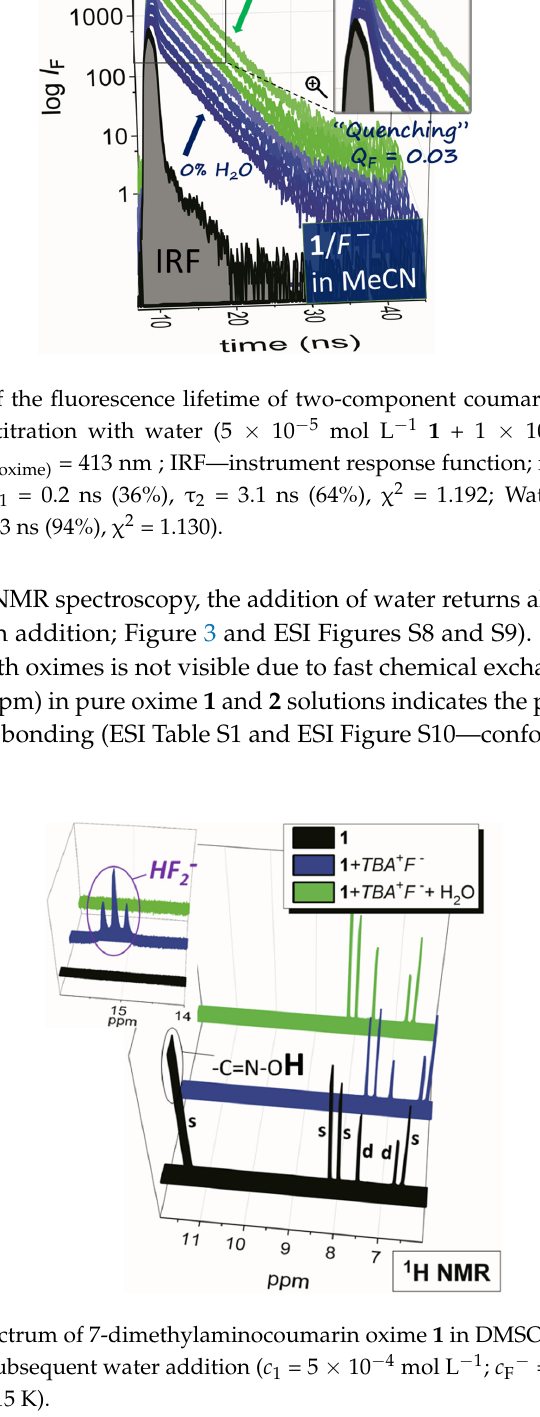
Figure 3. 1 H NMR spectrum of 7-dimethylaminocoumarin oxime 1 in DMSO- d 6 before and after F − anion (TBA + F − ) and subsequent water addition ( c 1 = 5 × 10 − 4 mol L − 1 ; c F − = 1 × 10 − 1 mol L − 1 ; 4% ( v/v ) of water; T = 298.15